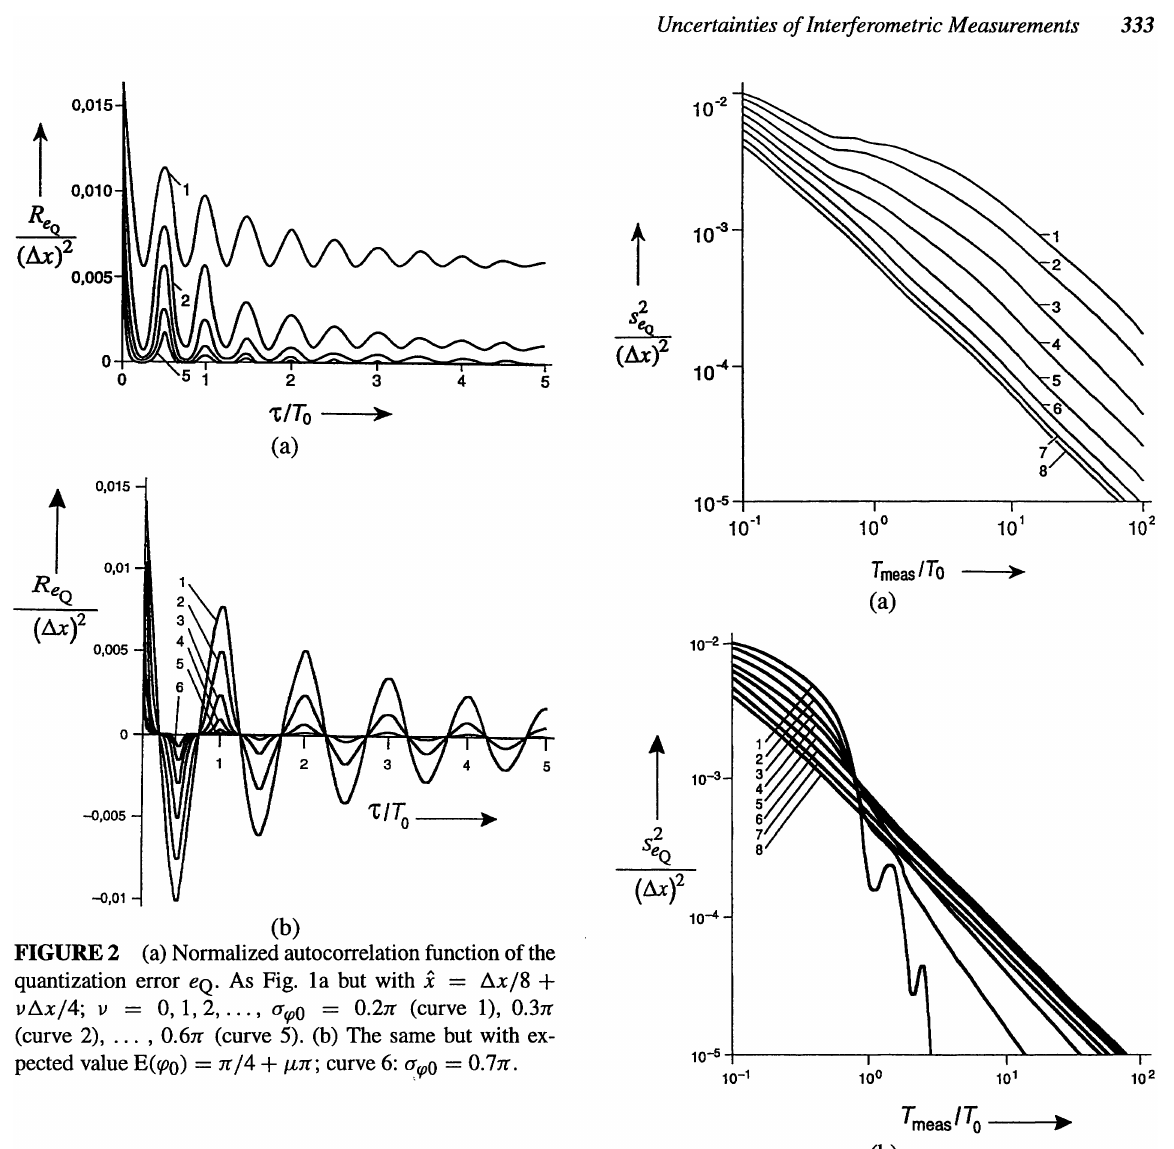
FIGURE 3 (a) Normalized variance of the quantization error eQ as a function of the measurement integration time. As Fig. 2a but with (jqJo = O.3n (curve 1), ... , l.On (curve 8). (b) The same but with expected value E(CPO) n/4+fJ-n